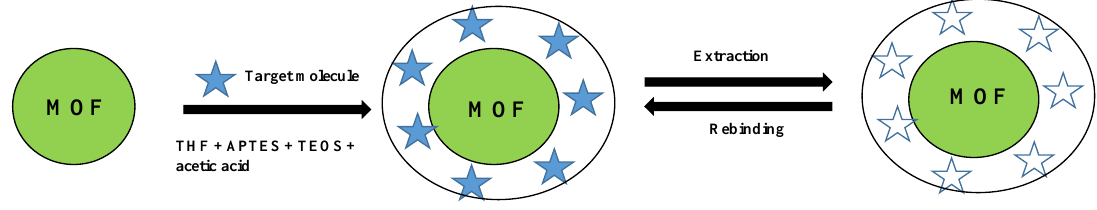
Figure 2. Structure of the molecularly imprinted core-shell nanoparticles using a MOF as core.